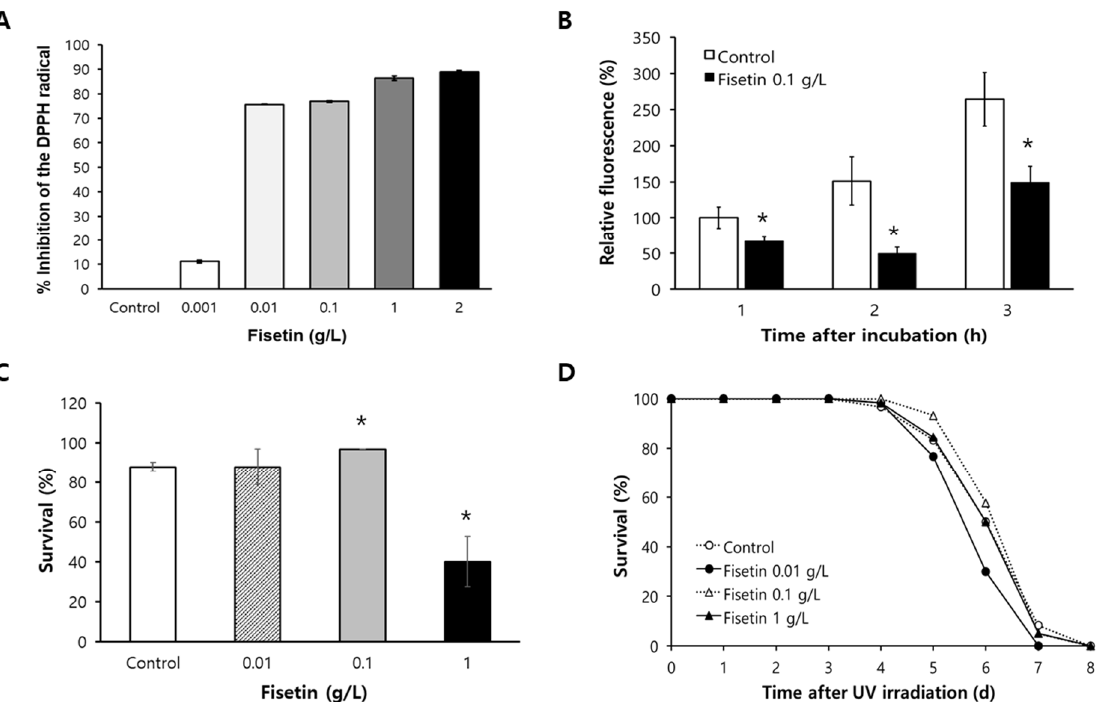
Figure 1. Effects of fisetin on oxidative stress and UV irradiation. ( A ) Radical-scavenging activities were measured with different concentrations of fisetin in vitro. ( B ) Cellular ROS levels in 7-day-old worms were compared between untreated control and fisetin-treated group. ( C ) Age-synchronized worms ( n = 30) pre-treated with different concentrations of fisetin were incubated with H 2 O 2 to induce oxidative stress for 6 h. Survival of worms was then compared to that of untreated control. ( D ) Effect of fisetin on response to UV irradiation was measured by recording daily survival rate after UV irradiation ( n = 60). Error bar indicates standard error. *, significantly different compared to untreated control ( p < 0.05). DPPH, 2,2-diphenyl-1-picrylhydrazyl; UV, ultraviolet.